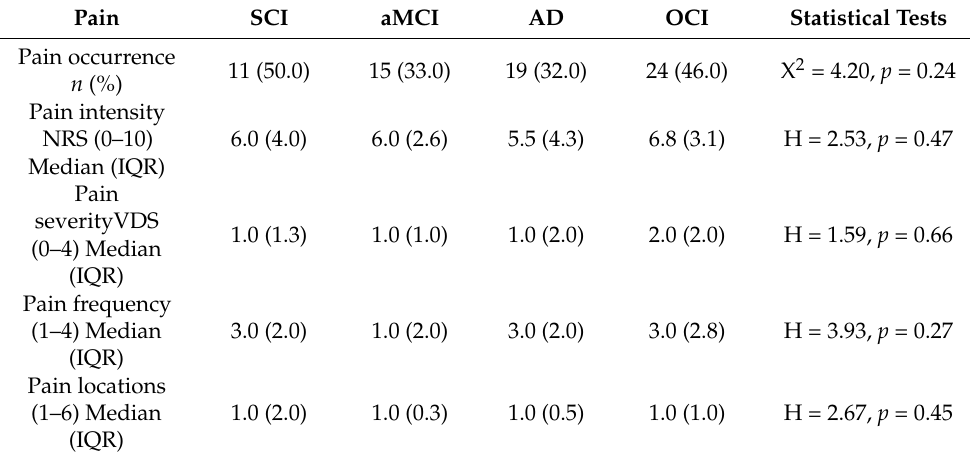
Table 2. Pain occurrence in the sample of patients categorized by diagnosis in groups of subjective cognitive impairment, amnestic mild cognitive impairment, dementia related to Alzheimer’s disease, and other cognitive impairments, and pain characteristics in the subsample of patients who self- reported pain. Pain SCI aMCI AD OCI Statistical Tests Pain occurrence 11 (50.0) 15 (33.0) 19 (32.0) 24 (46.0) X 2 = 4.20, p = n (%)